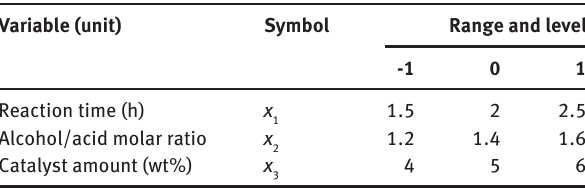
Table 1: List of experimental variables and coded values and levels adopted in this study.